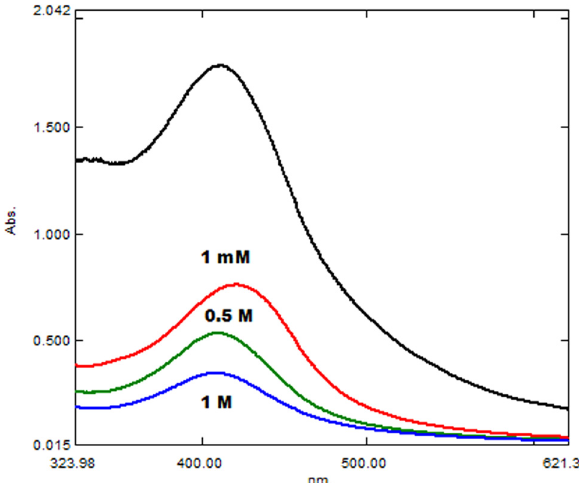
Figure 4: Comparison of UV - Vis spectra of AgNPs stability at di ff erent temperatures.